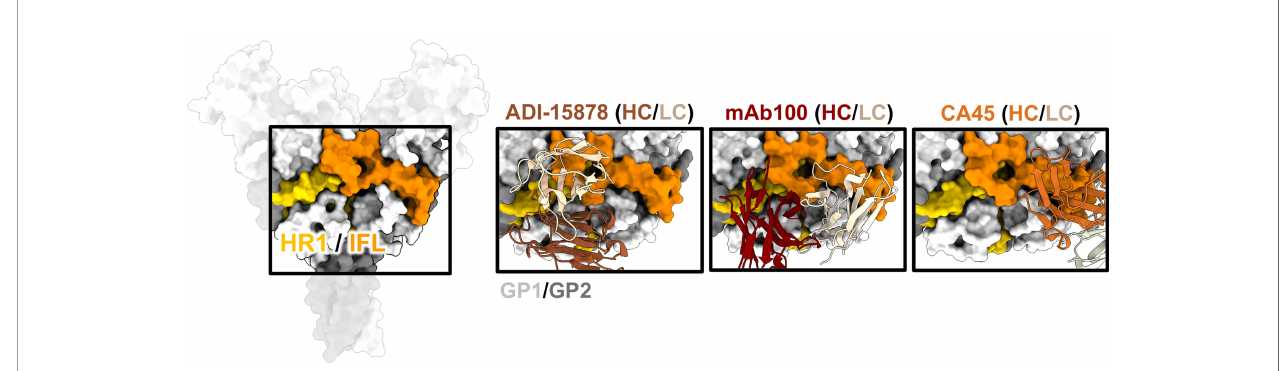
FIGURE 6 | The IFL and HR1. The HR1 domain (yellow) and IFL (orange) form a belt around the middle of GP and antibodies that bind to this region often have overlapping contacts in both these regions. ADI-15878 (left, PDBID: 6DZL) uses a mechanism of induced- fi t to mimic GP1 interactions with HR2 and simultaneously access conserved residues in the tip of the IFL. MAb100 (middle, PDBID: 5FHC) binds a very similar epitope to ADI-15878 but has a broader footprint and thus contacts several less-conserved residues making it monospeci fi c. CA45 (right, PDBID: 6EAY) does not contact HR1, focusing more on the base of the IFL and has some broad